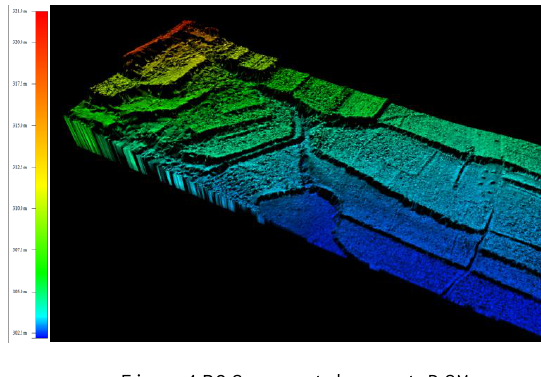
Figure 4 POS-supported generate